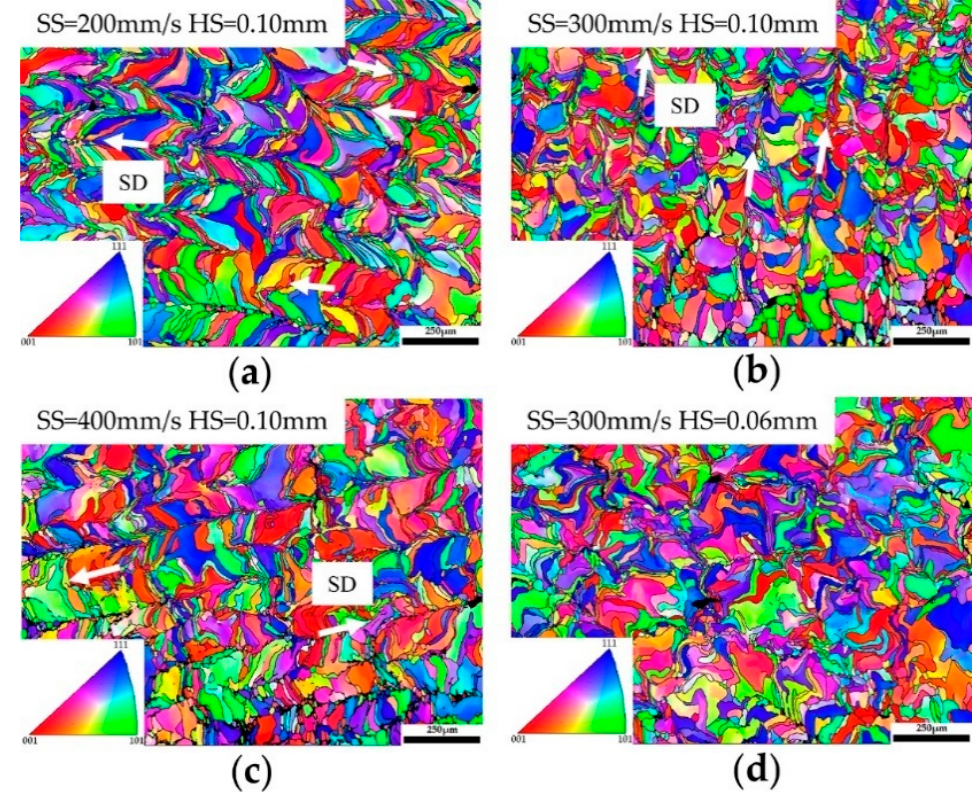
Figure 10. Electron backscattered diffraction (EBSD) images of the cross-section at different scanning speeds and hatch spacing. ( a ) T21, ( b ) T24, ( c ) T27, ( d ) T22.